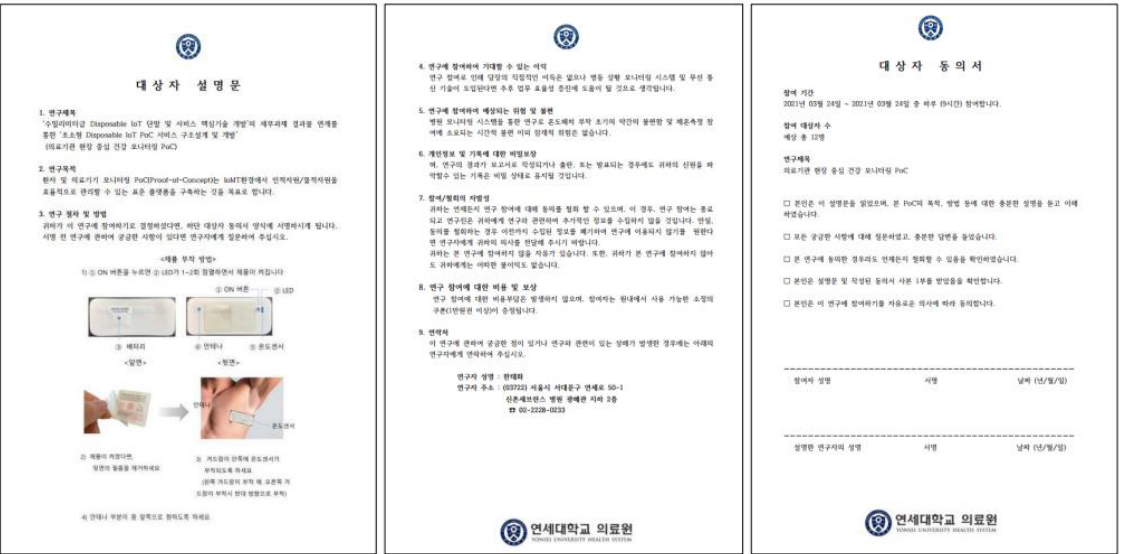
Figure 9. Non-Hospital Network System.